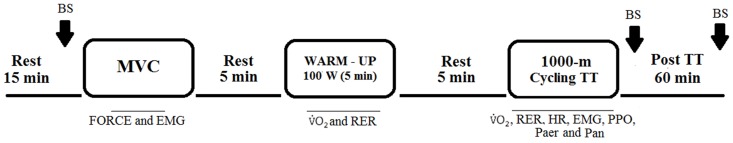
Experimental Protocol.BS: blood sample; MVC: maximal voluntary contraction; EMG: electromyographic activity;  O2: oxygen uptake; RER: respiratory exchange ratio; HR: heart rate; PPO: power output; Paer: aerobic mechanical power output; Pan: anaerobic mechanical power output.